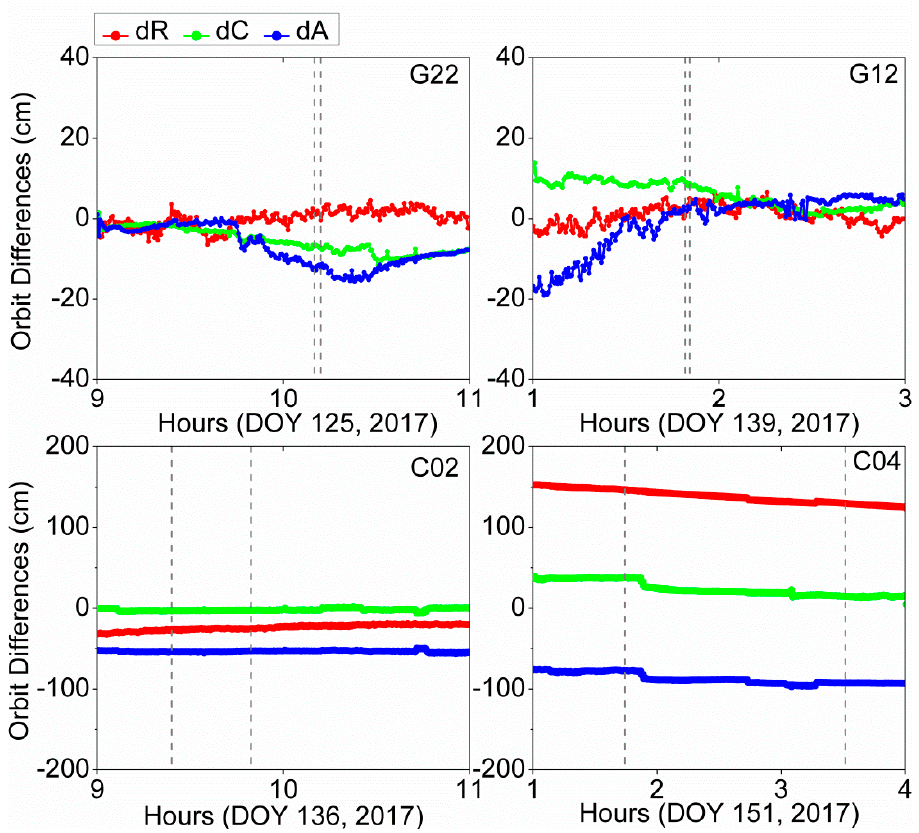
Figure 8. Orbit differences between the forward and backward RPPP solutions for G22, G12, C02 and Figure 8. Orbit di ff erences between the forward and backward RPPP solutions for G22, G12, C02 and C04 around maneuvers. C04 around